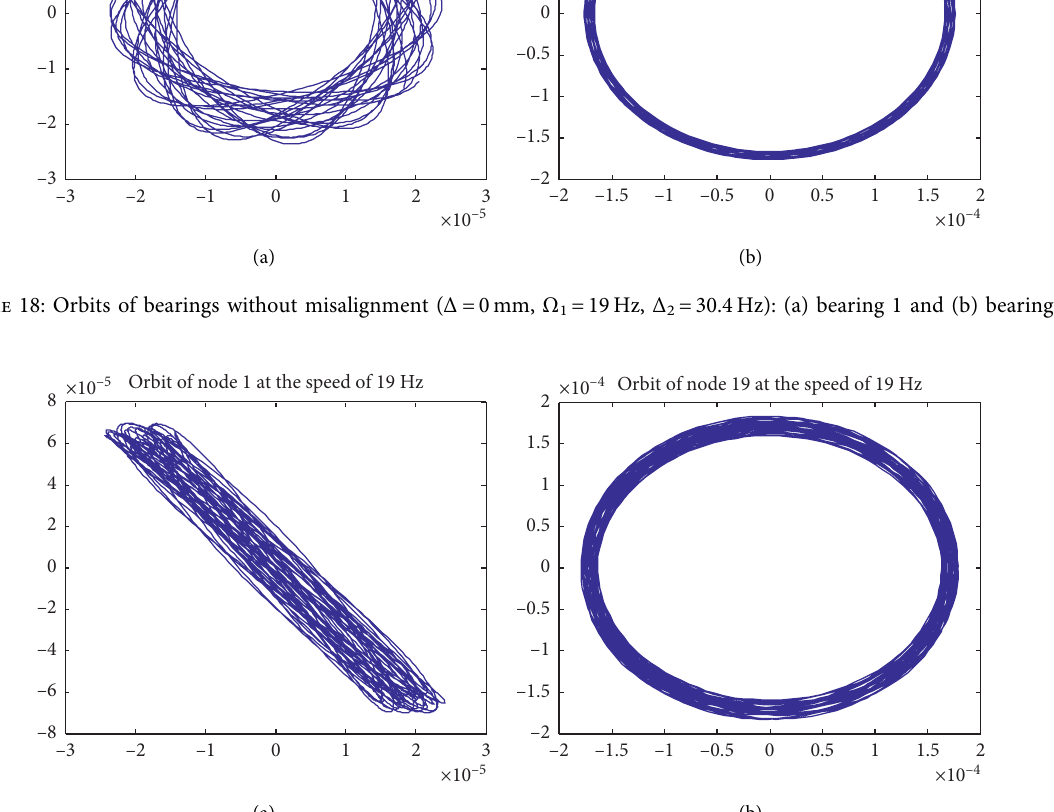
Figure 19: Orbits of bearings with misalignment ( Δ � 0.1mm, Ω 1 � 19Hz, Ω 2 � 30.4Hz): (a) bearing 1 and (b) bearing 4.